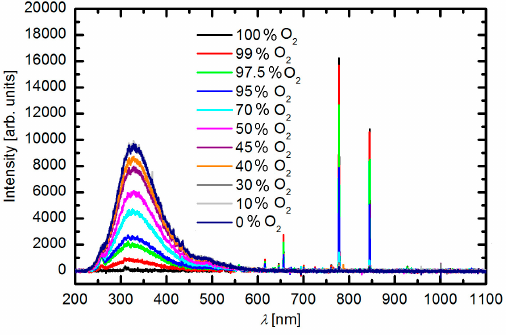
Figure 2. Spectra of plasma sustained in various gas mixtures. Parameter is the oxygen concentration in the SO 2 + O 2 mixture.